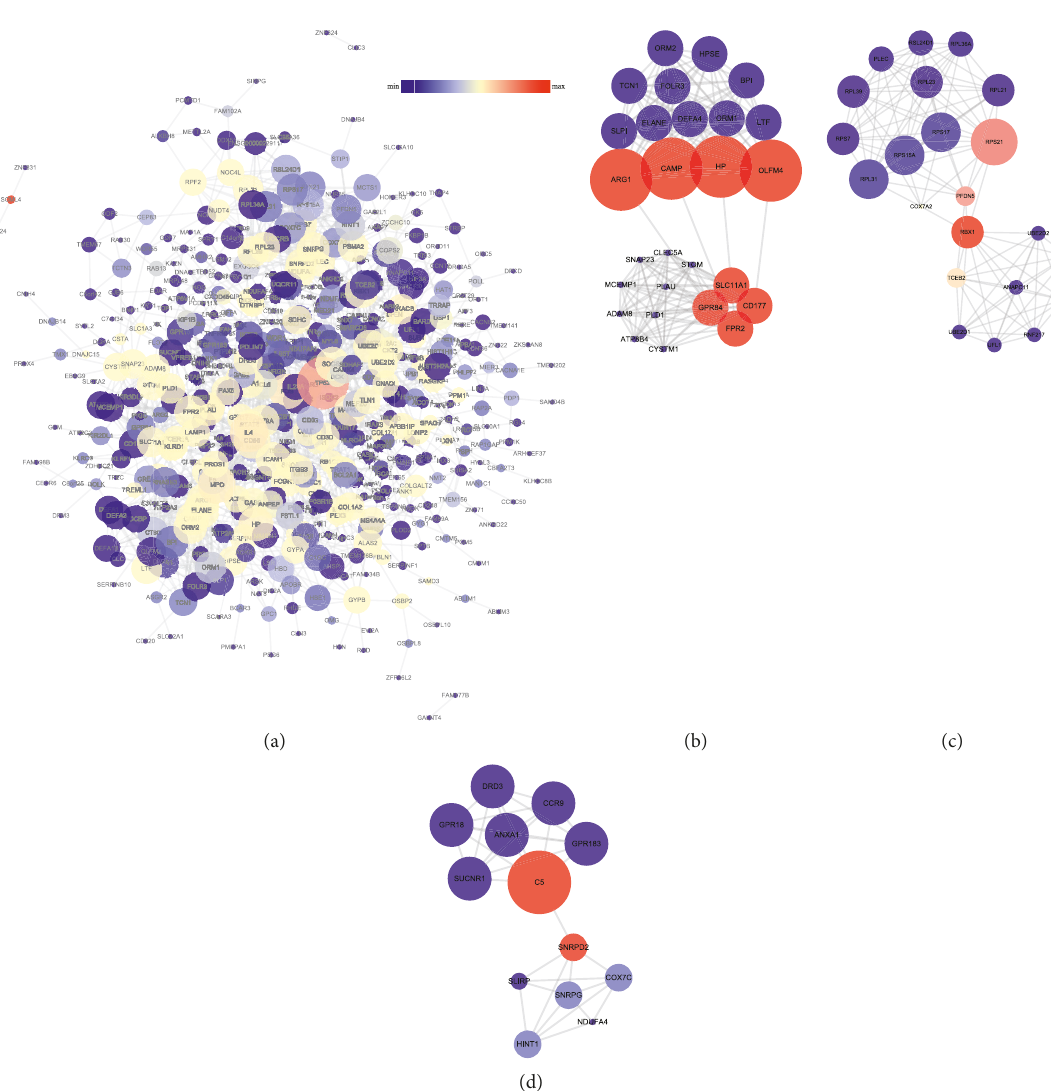
Figure 5: Analysis of the PPI network of DEGs2. (a) PPI network of OMGs2 and VTEGs2. (b) Module 1 of the PPI network of DEGs2. (c) Module 2 of the PPI network of DEGs2. (d) Module 3 of the PPI network of DEGs2. The node sizes correspond to the degree of the node, while the node color denotes betweenness